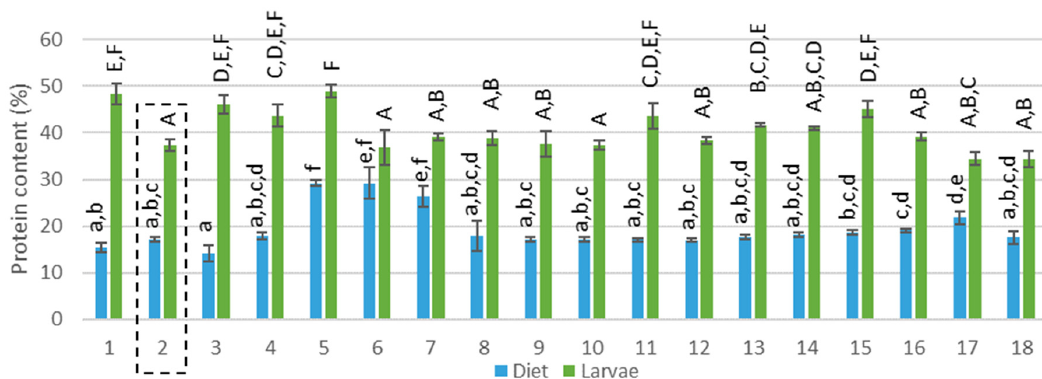
Figure 1. Protein content (% on dry matter basis) of the diets and corresponding larvae. Diet 2 (reference diet) is framed, capital letters represent the pairwise comparison after the Kruskal–Wallis analysis performed on the protein content of the larvae while regular letters represent the pairwise comparison after the Kruskal–Wallis analysis performed in the protein content of the diets.